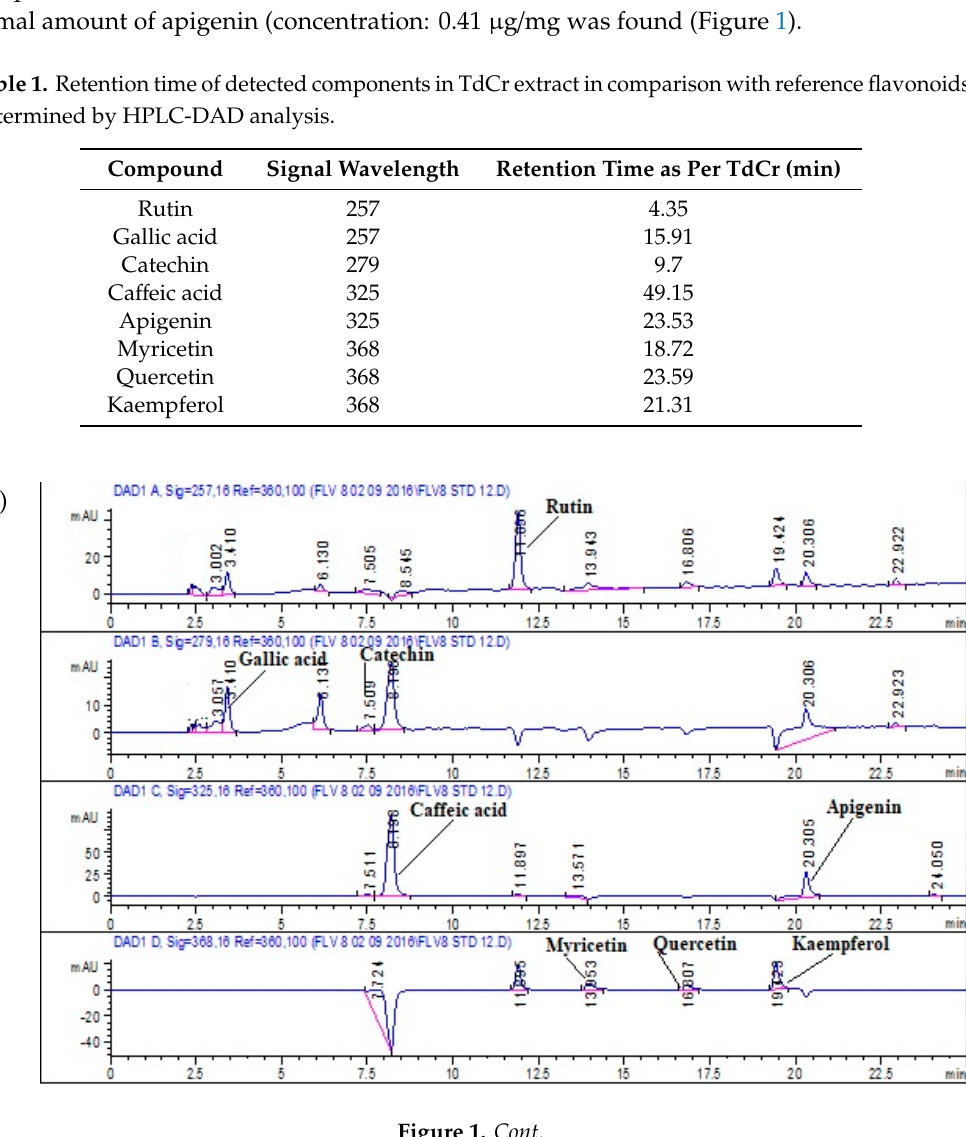
Figure 1. HPLC-DAD chromatograms of ( a ) Standard at 257, 279, 325, and 368 nm; ( b ) Methanolic extract of TdCr extract at 257, 279, 325, and 368 nm. 3.2. In Vivo Experiments 3.2.1. Antidiarrheal Activity in Rats The methanolic extract of T. dioica had a significant antidiarrheal effect when orally administered at doses of 100.0, 200.0, and 400.0 mg/kg. It exhibited prominent inhibition of loose stools compared to the control group of 13.62% ( p < 0.05), 45.0% ( p < 0.01) and 60.62% ( p < 0.005), respectively. The positive control, loperamide (3 mg/kg), caused a 74.1% ( p < 0.005) inhibition, which was found to be the maximum. The control saline group (NS, 10 mL/kg) caused negligible inhibition of diarrhea. The results were statistically evaluated by ANOVA (one-way) and multiple comparison by Dunnett’s test and presented in a bar graph (Figure 2).